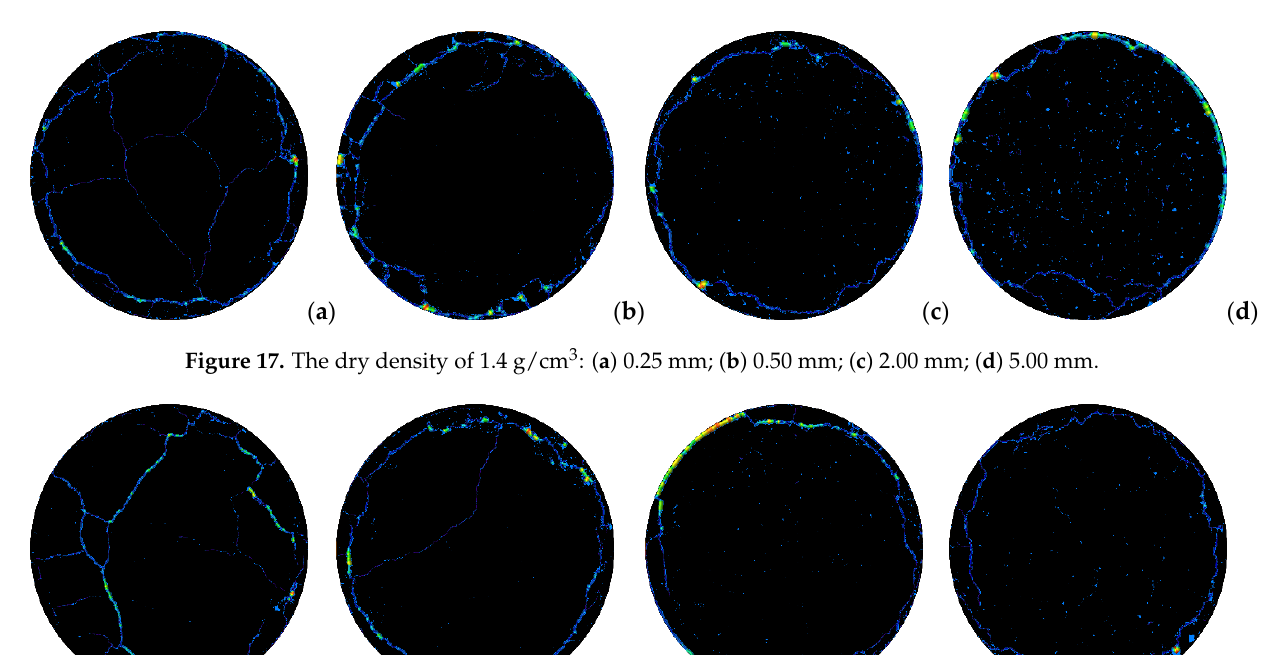
Figure 16. The dry density of 1.3 g/cm 3 : ( a ) 0.25 mm; ( b ) 0.50 mm; ( c ) 2.00 mm; ( d ) 5.00 mm.